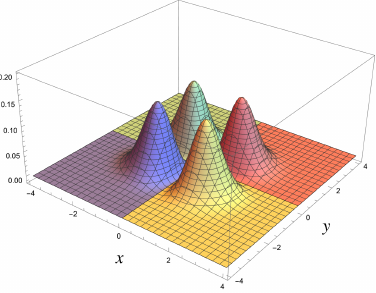
Figure 1 . The shape of the four-hill